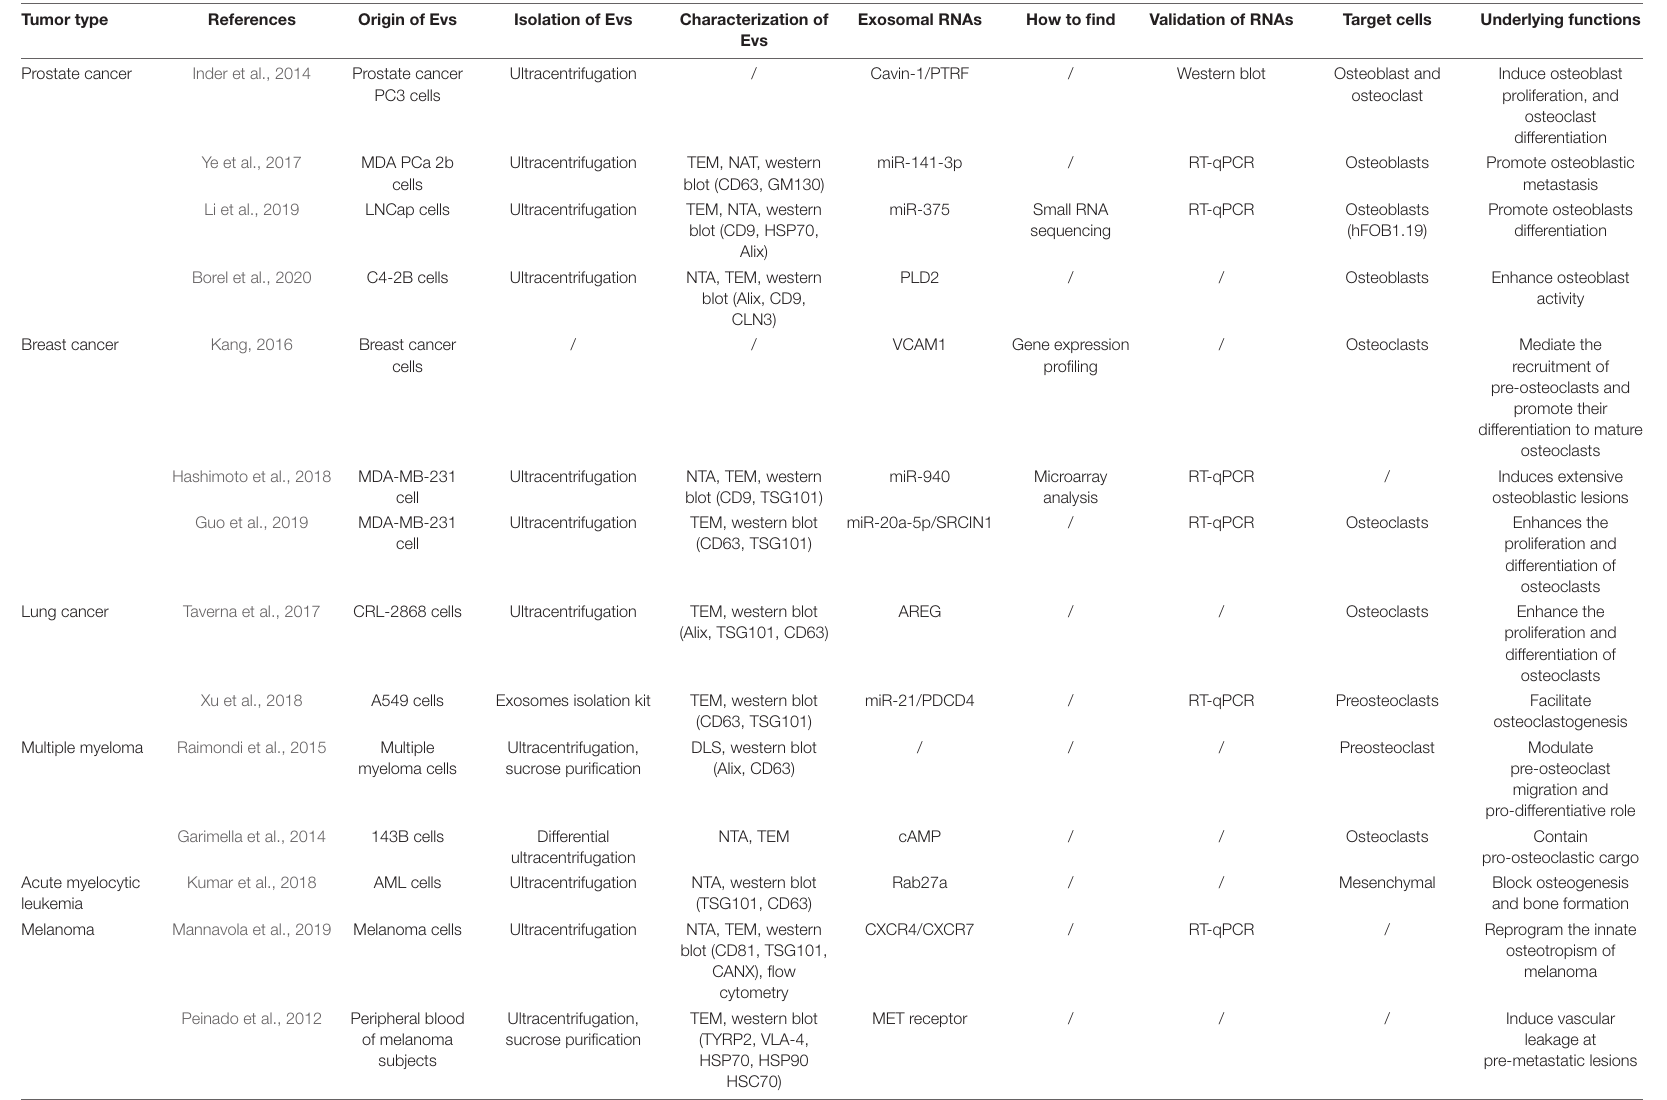
TABLE 2 | Studies reporting the roles of tumor-derived extracellular vesicles in the development and progression of bone